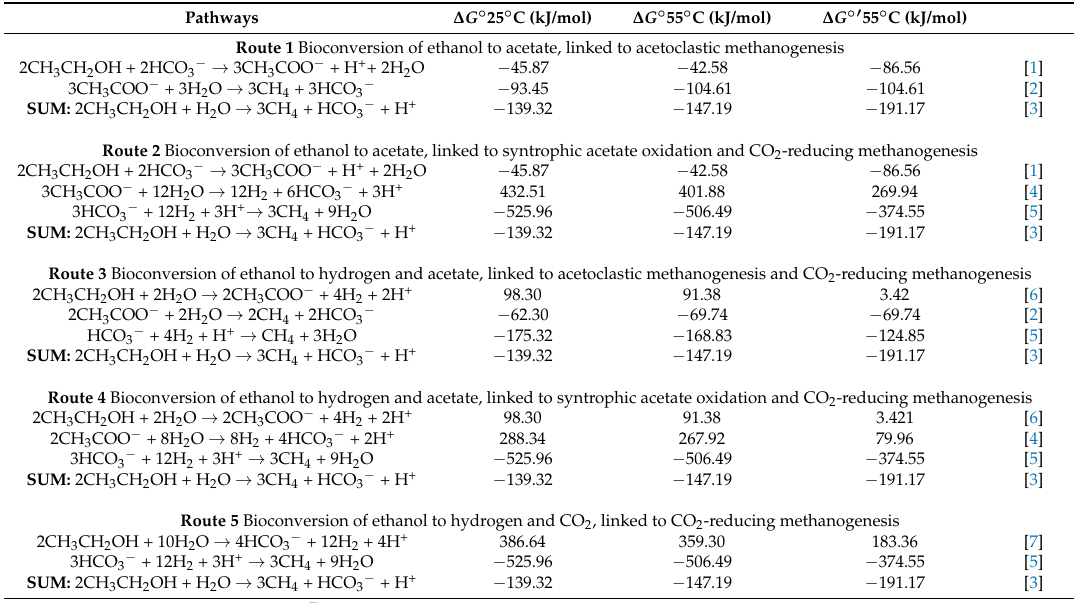
Table A1. Gibbs free energy changes for the feasible chemical processes at 328.15 K and neutral pH (pH =